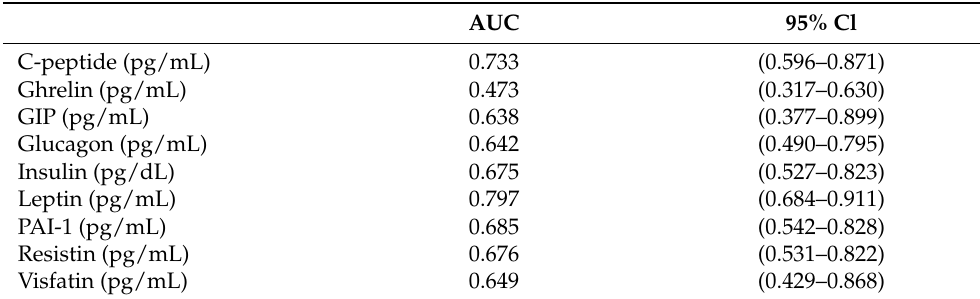
Table 6. The receiver operating characteristic (ROC) analysis for prediction of at least one metabolic risk factor based on the diabetes markers levels in childhood acute lymphoblastic leukemia survivors.